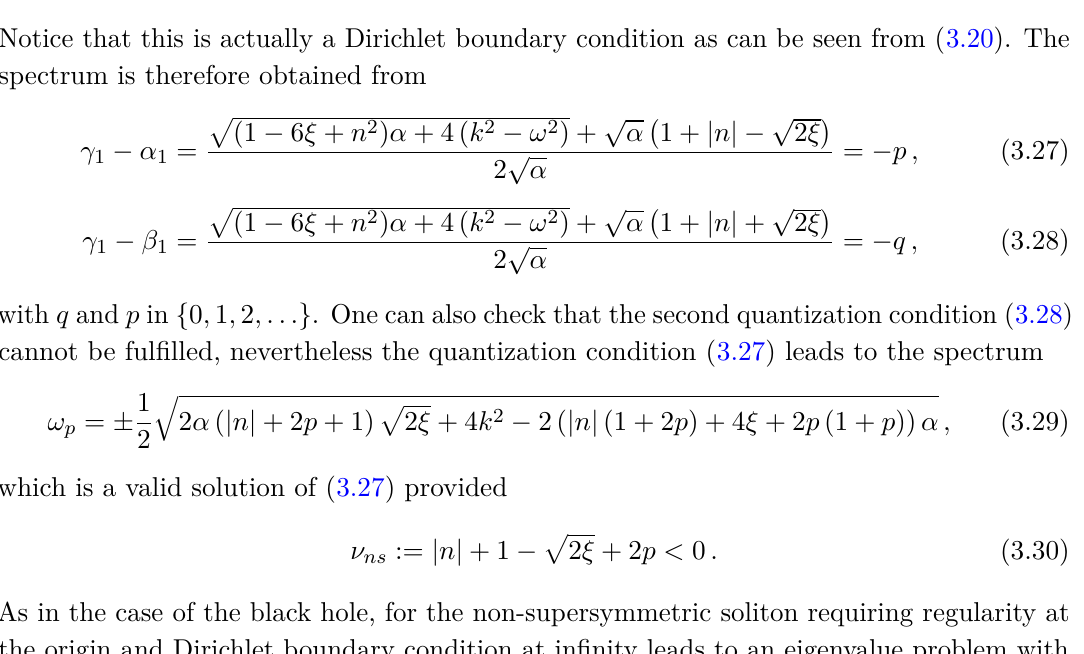
Figure 2 . The panels show the spectra of stable and unstable modes of the non-minimally coupled scalar probe on the background of the non-supersymmetric soliton. Valid solutions for the quantization equation leading to the frequencies require ν p < 0 , therefore in both panels, to the left of the vertical black line, there are no allowed modes given our boundary